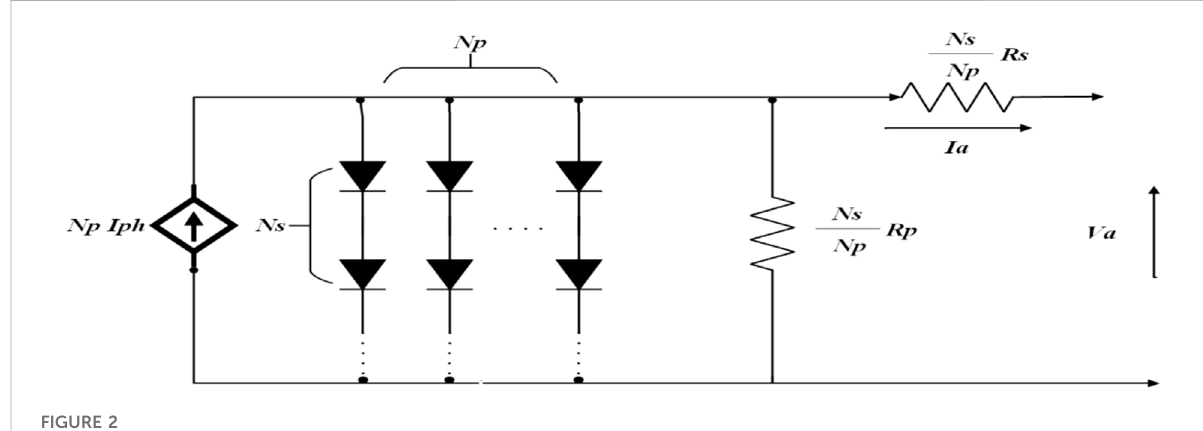
FIGURE 2 Equivalent circuit for solar